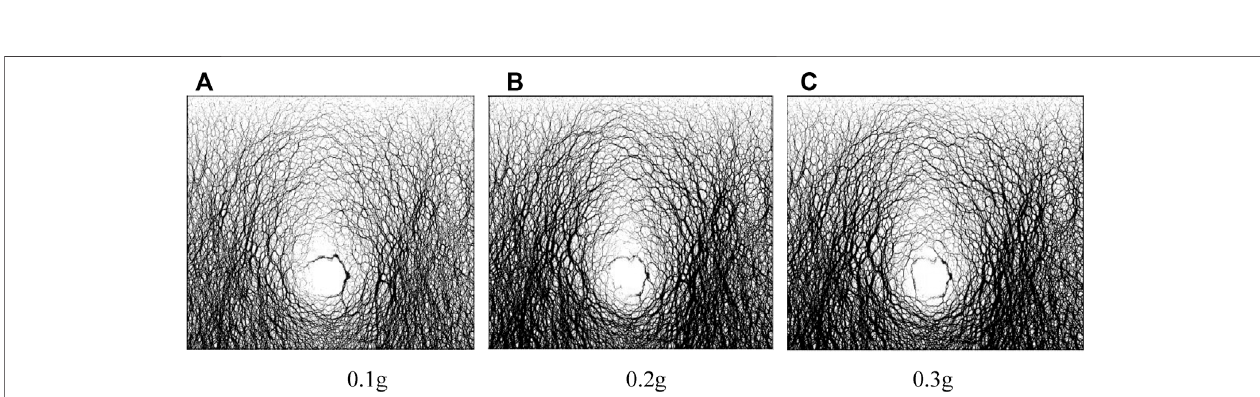
FIGURE 8 | Force chain patterns of circular tunnels under earthquake of various spectra. (A) El Centro earthquake. (B) Kobe earthquake. (C) Wenchuan earthquake.